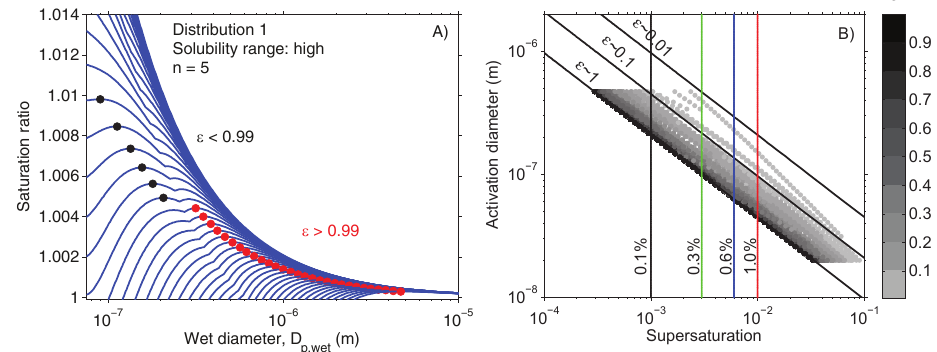
Figure 3. (a) Examples of Köhler curves for the flat logarithmically spaced solubility distribution (distribution 1 in Table 2) with n = 5 and the high solubility range (Table 2). The dots indicate the point of activation, black indicating incomplete dissolution ( ε <1) and red complete dissolution ( ε = 1). (b) The activation points determined from the model calculations (in total, 7200 Köhler curves; see Table 2), corresponding to in total 5957 points in the activation dry diameter vs. supersaturation space. Also, the dependence of the dissolved fraction at the point of activation is